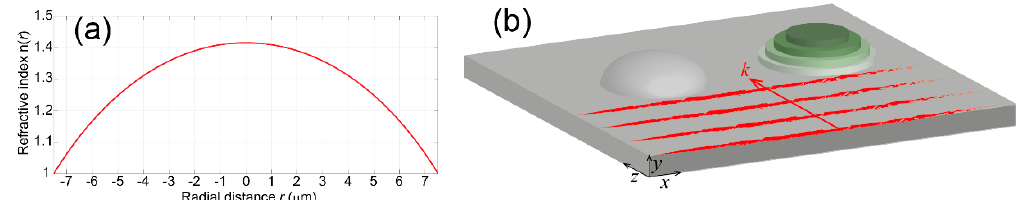
Figure 1. ( a ) Gradient index profile for a standard Luneburg lens in air with n 0 = 1 and R = 7.5 μ m. ( b ) Schematic of 2D Luneburg lenses for continuous and stepwise index profiles. Surface wave propagates along the z -axis.